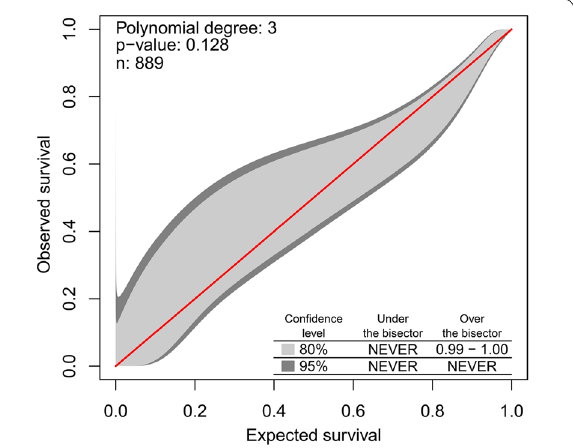
Fig. 2 Calibration belt for logistic regression model examining the effect of workload/staffing ratio threshold set at 40 on